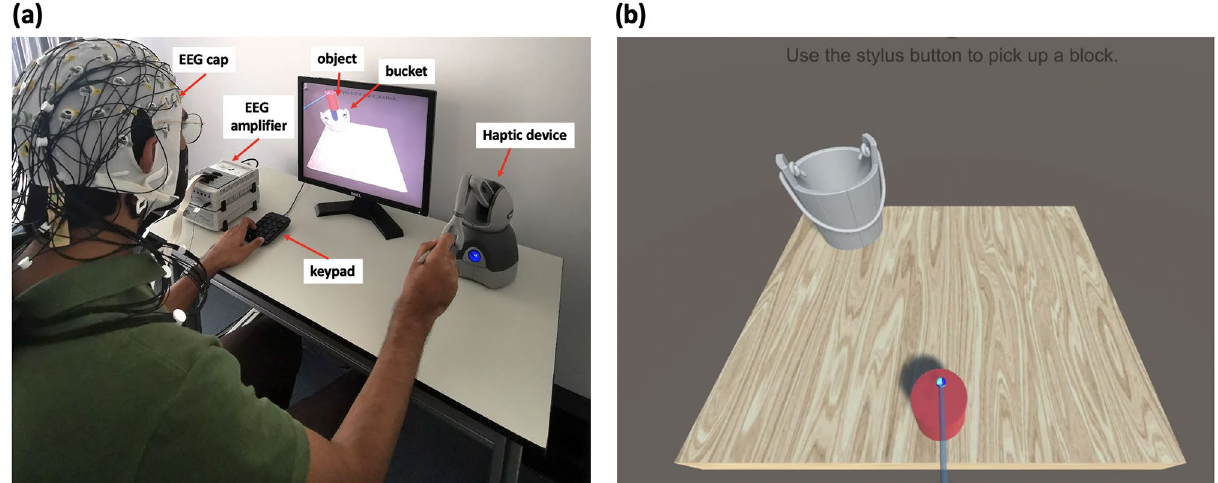
Figure 1. A 64-channels EEG cap is placed on the participant’s head. Wet electrodes are connected to the EEG amplifier. The participant controls the movement of the stick shown on the screen to pick up the object using the haptic device. The participant holds the stylus of the haptic device with their right hand to control the movement of the stick shown on the screen. The participant’s thumb is placed on the button integrated into